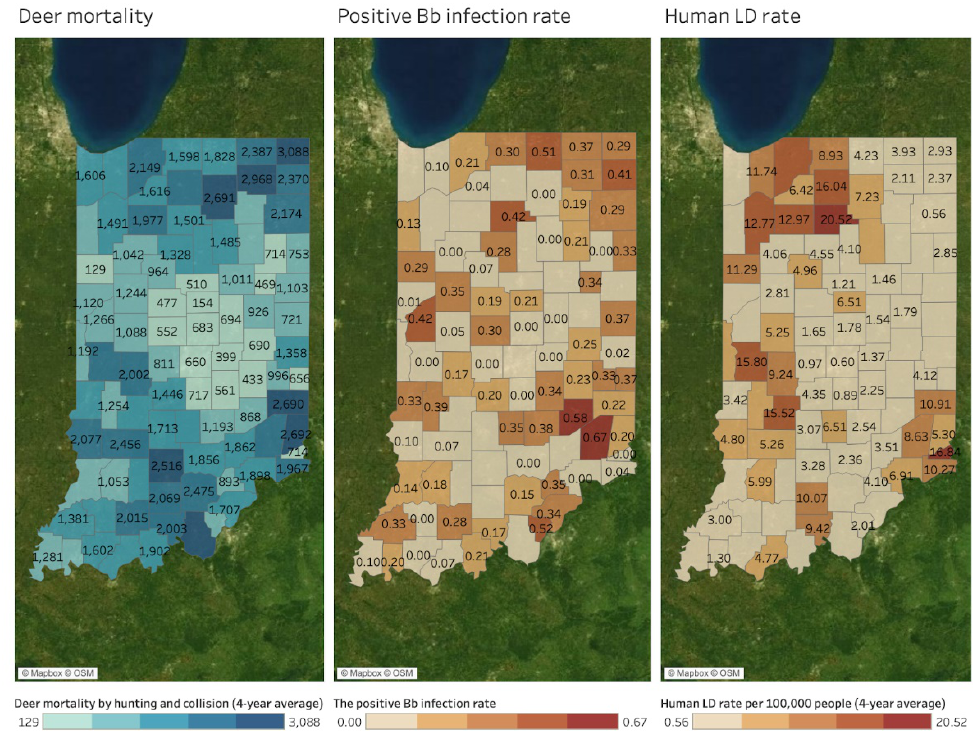
Figure 6. Deer mortality, the positive Bb infection rate, and human LD rate by county (4-year average between 2017 and 2020).